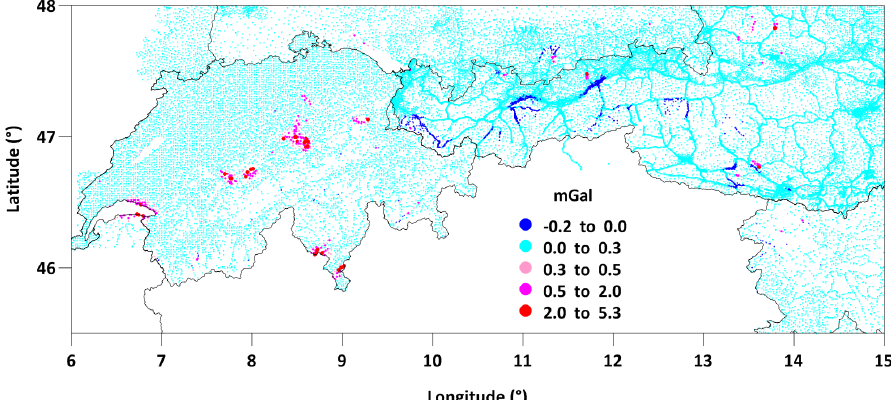
Figure 7. Map of lake corrections (correction density is 1670kgm − 3 ). Small negative values occur in deep valleys with topography below the level of lakes (dark blue points). No corrections were calculated for the upper Italian lakes because no lake bottom information was